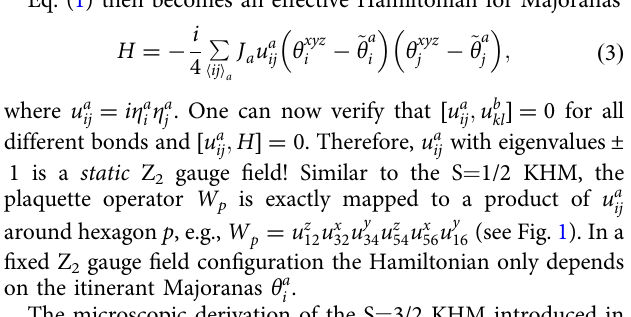
Fig. 2 The ground-state phase diagram and the values of parameter Q xy . a The MF phase diagram of Hamiltonian (5) in zero- fl ux sector on a 36 × 36 torus. The A 0 phase is a Dirac QSL with spin quadrupolar parameter Q xy < 0. In the A z ( B ) phase, the Majorana excitations are gapped with Q xy < 0 ( Q xy > 0). At the isotropic point, the ground state is a QSL with Q xy = 0. The bold blue line at D z = ∞ with J z < 8 ( J z > 8) represents the effective gapless (gapped) S = 1/2 KSL. The gapless phases in S = 3/2 and S = 1/2 KHMs can continuously connect to each other through the A 0 phase without energy gap opening. The orange stars (green triangles) represent the ground states obtained by DMRG on a 3 × 4 torus with zero- fl ux (disordered- fl ux) con fi gurations with bond dimension χ = 4000. The values of Q xy as a function of J z with D z = 0 ( b ) and D z with J z = 7 ( c ). The computations of DMRG and parton MF theory are performed on a 3 × 4 torus.